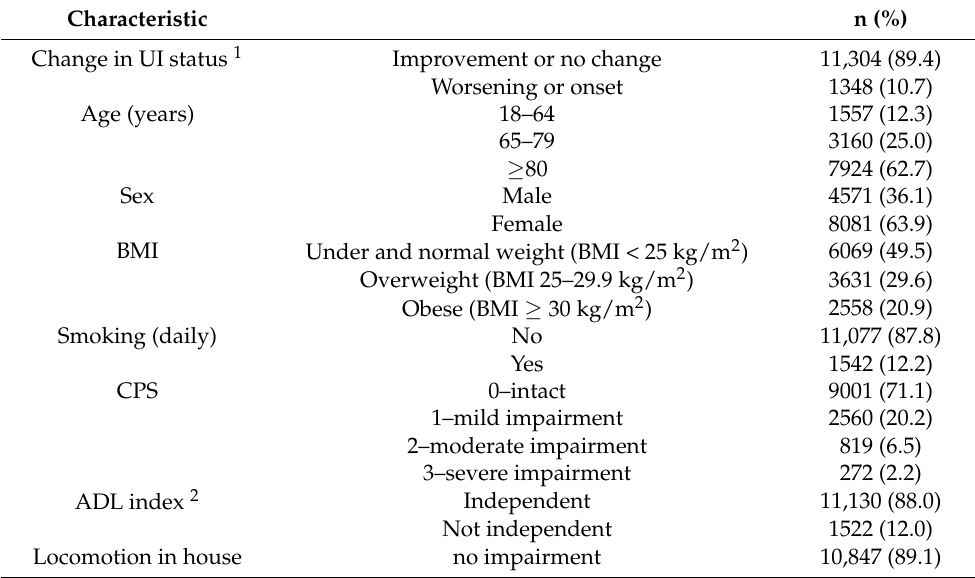
Table 2. Characteristics of the study population ( n = 12,652